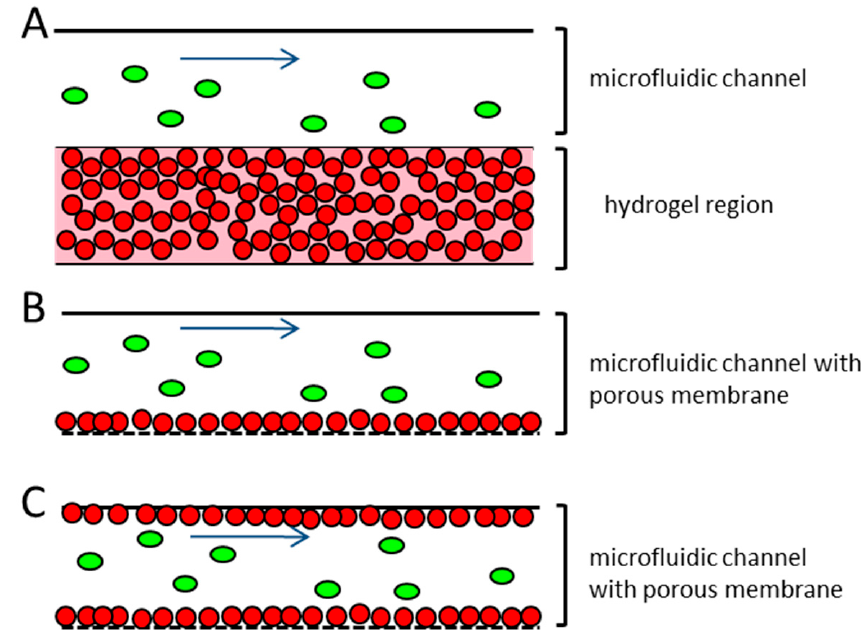
Figure 1. Schematic representation of different microfluidic systems used for the research on the vessel associated steps of the metastatic cascade ( A ) endothelial cells are embedded in hydrogel and injected into the microfluidic channel, where they are arranged in a capillary network. Tumor cells are introduced to the top of the hydrogel, and can migrate into it. No perfusion of the tubule-like structures takes place; ( B ) Endothelial cells are seeded in a monolayer on top of a porous membrane. The confluency of the endothelial cells on the membrane can often not be guaranteed. The tumor cells are introduced to the system under flow conditions; ( C ) Proposed microfluidic device. Endothelial cells are seeded to the total dimension of the microfluidic channel and the adjacent porous membrane, representing the vessel equivalent. The confluency of the endothelial cells is confirmed before the experiment. Tumor cells are introduced to the device under different flow conditions. Red dots—endothelial cells; green ovals—tumor cells; blue arrow—direction of flow.